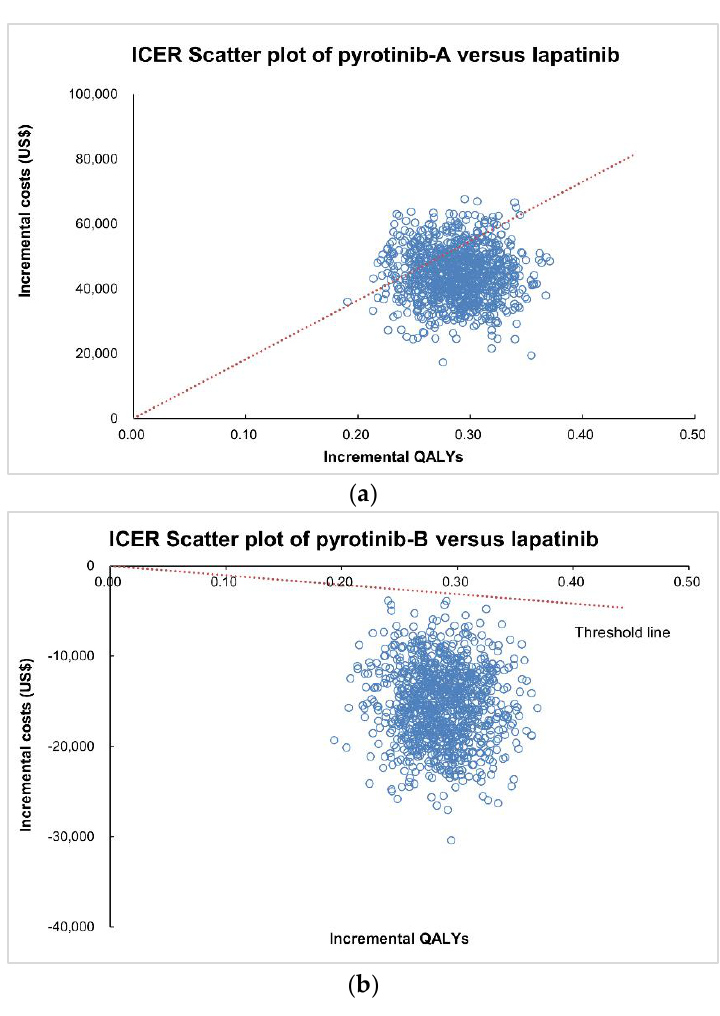
Figure A1. ICER Scatter plot. ( a ) ICER Scatter plot of pyrotinib-A plus capecitabine versus lapa- tinib plus capecitabine; ( b ) ICER Scatter plot of pyrotinib-B plus capecitabine versus lapatinib plus capecitabine. Abbreviations: ICER, Incremental cost-effectiveness ratio; pyrotinib-A, pyrotinib before being enrolled in the National Reimbursement Drug List; pyrotinib-B, pyrotinib after being enrolled in the National Reimbursement Drug List.